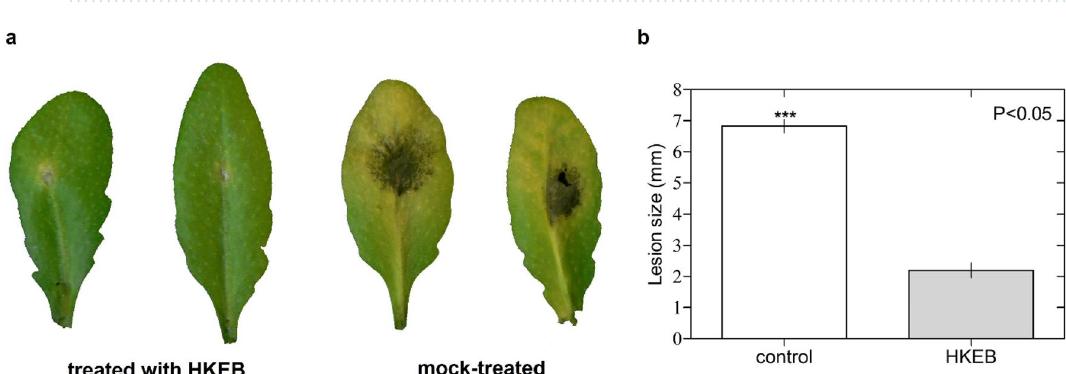
Figure 6. B. aryabhattai HKEB induced an effective defense against B. cinerea infection in Arabidopsis plants. ( a ) Disease symptom evaluation in Arabidopsis plants that were treated with HKEB and mock-treated at 72 h post inoculation. ( b ) The lesion size produced by B. cinerea . The bars represent the mean values and standard errors of the means (n = 10). The experiments were replicated three